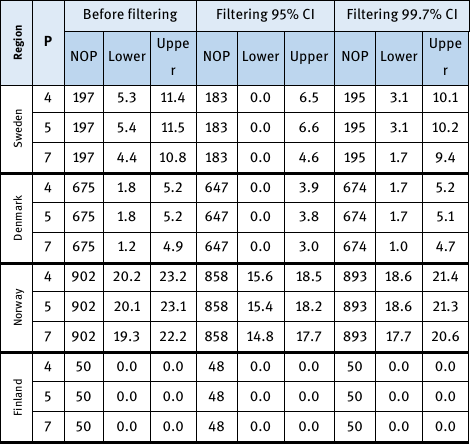
Table 6. Confidence intervals based on the confidence of 95% for the error of the NKG2015 geoid model. NOP means number of points, P is the number of parameters in the used corrective